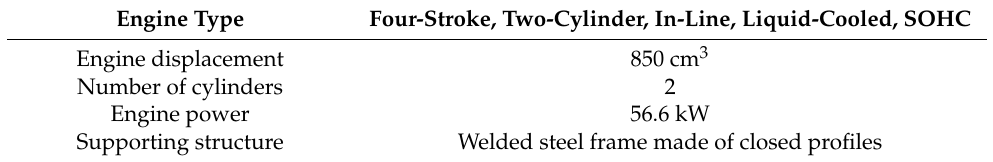
Table 1. Technical data of the test object (Polaris Sportsman XP